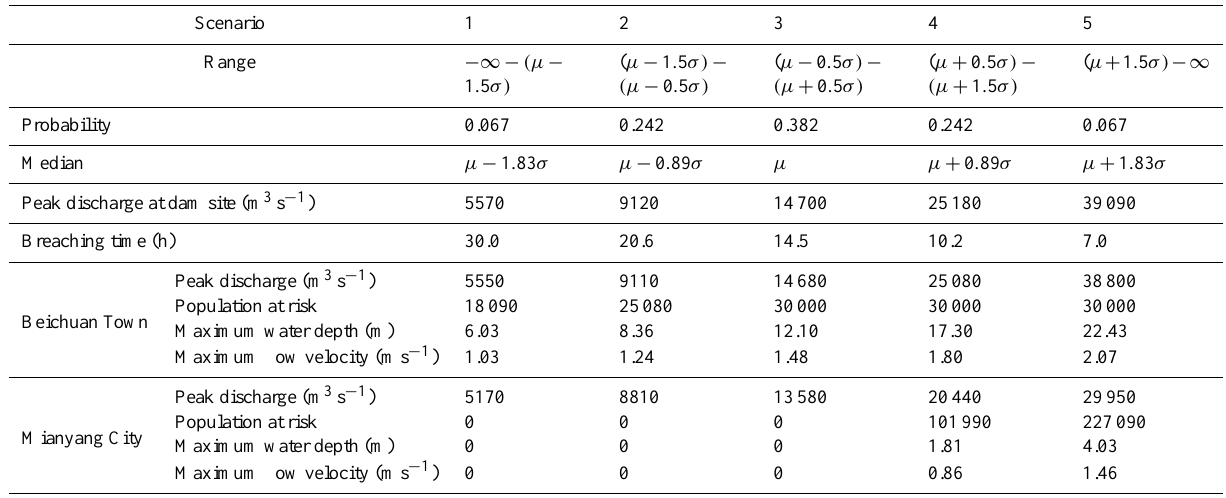
Table 6. Dam-break floods in Beichuan Town and Mianyang City in stage 2. Scenario